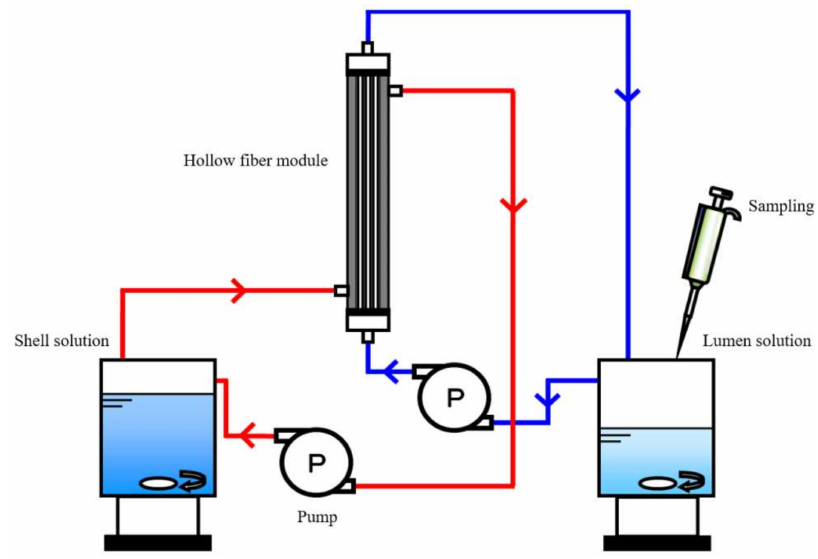
Figure 5. Schematic diagram of apparatus of Donnan dialysis experiments.